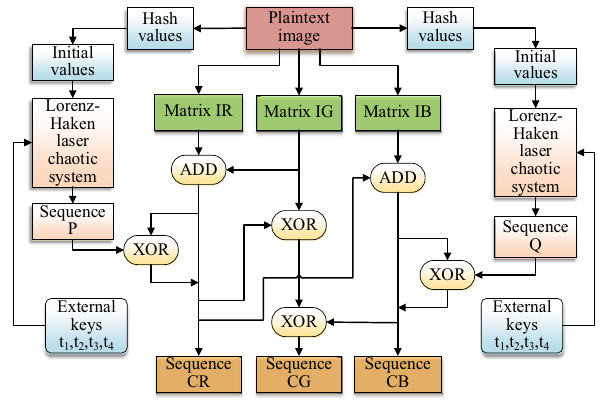
Fig. 2 The flowchart of PSLS